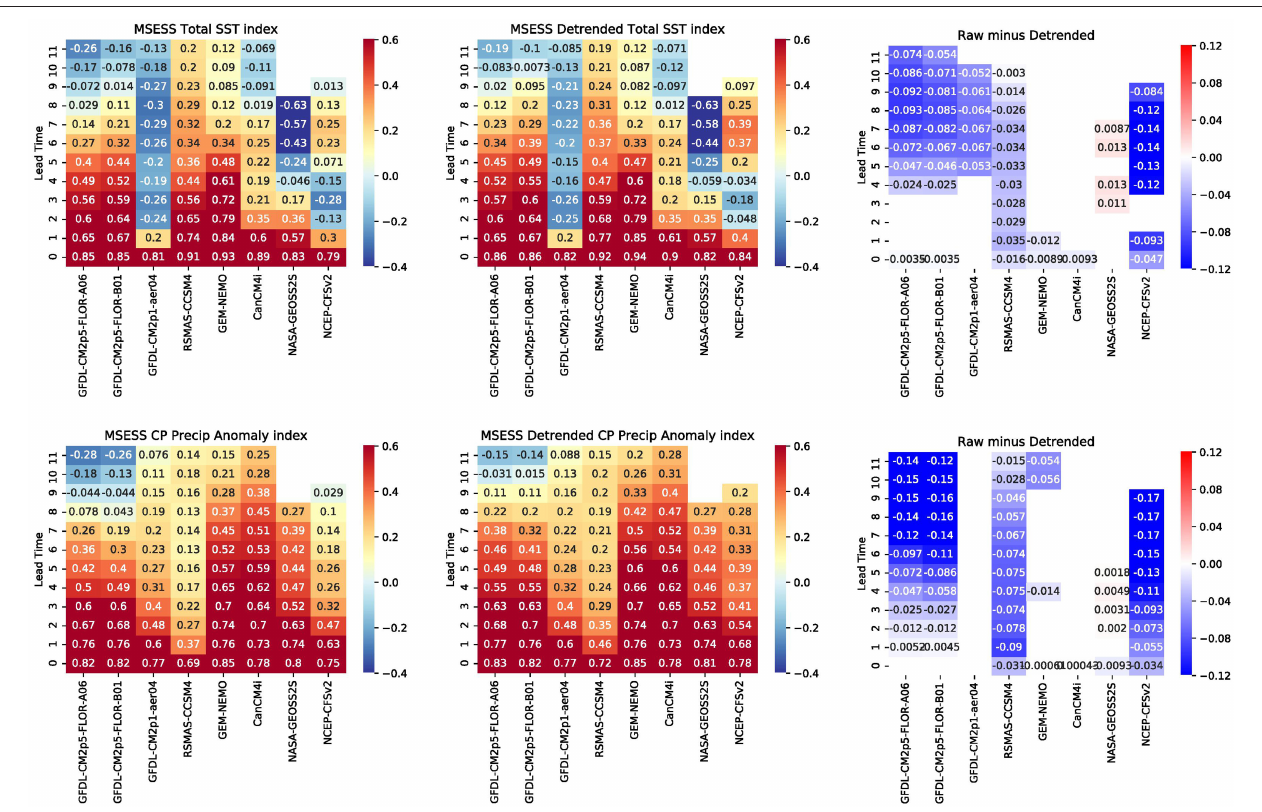
FIGURE 12 | (Top) Heat map of Mean Squared Error Skill Score (MSESS) for the total SST index, including the (left panel) SST trend (middle panel) and for linearly detrended SSTs and (right panel) difference between the left and right panels. (Bottom) Same as the top row except for the central Pacific precipitation anomaly index. Shading is only shown where differences are statistically significant at the 95% level. MSESS is unitless and is positive for forecasts whose MSE is less than the observed